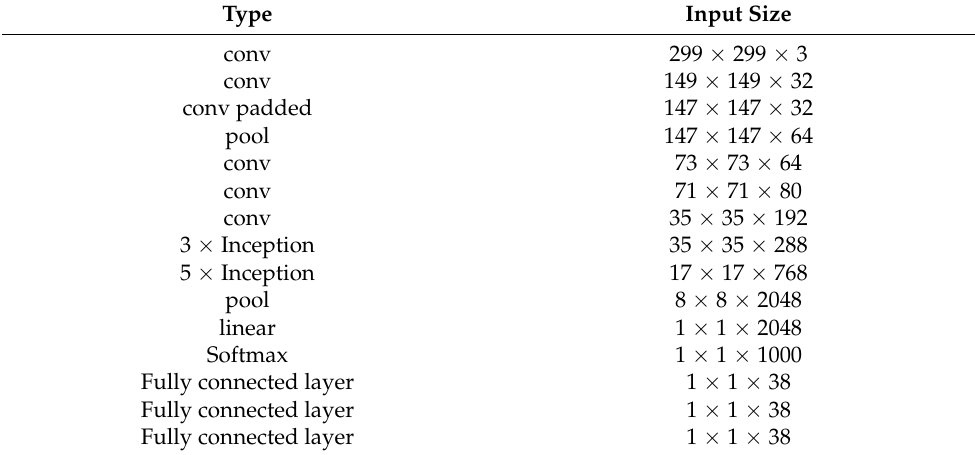
Table 3. A summary of the Inception v3 architecture in terms of input size requirements for every layer of the network.